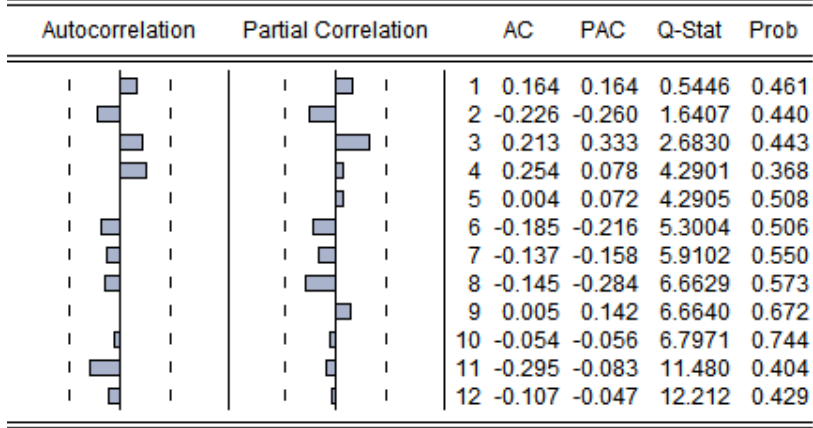
Figure 4. Autocorrelation (AC) and partial autocorrelation (PAC) coefficients.